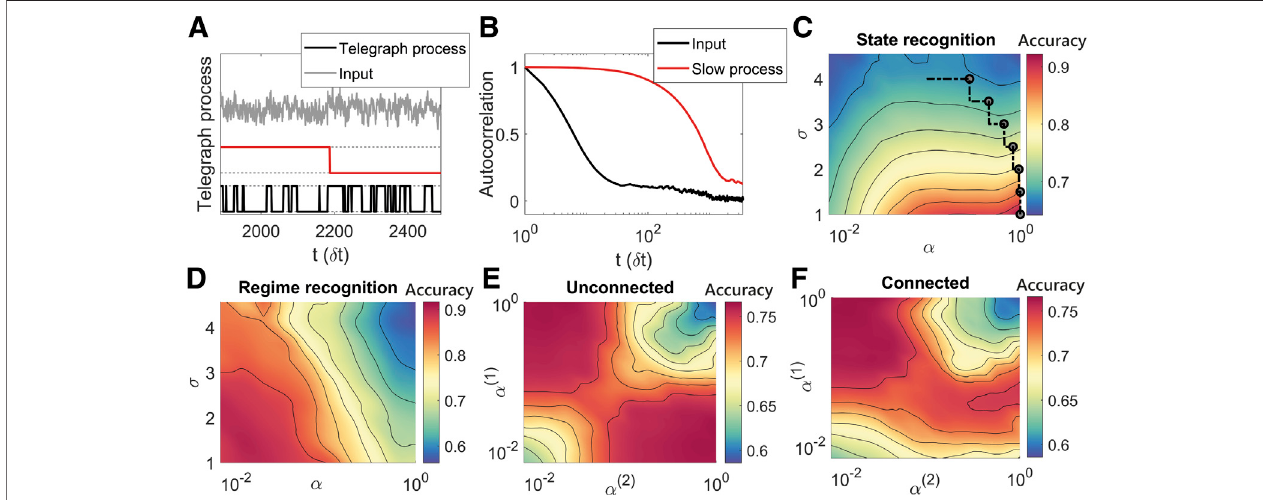
FIGURE4| Thebeststructureandparametersofthemodeldependonthespeci fi cenvironmentconsidered,thatisdifferentvaluesoftheadditivenoiseintheinput signal,and on thespeci fi c desired output. (A) : Example ofinputsignal and ofits generativeprocesses, which have afaster and aslower dynamic respectively. When the slowerprocess(redline)is up ( down ),theothersignalisinaregimewheretheaveragetimeinthezero(one)stateisgreaterthantheaveragetimespentintheotherstate. Theinputsignal(grayline)correspondstothefasterprocess(blackline)withadditionalwhitenoise. (B) :Auto-correlationstructureofthetwogenerativeprocesses. (C) :TheaccuracysurfaceforasingleESNonthestaterecognitionsub-taskforvaryinglevelofnoise( σ )andleakagerateofthenetworkshowingthatforincreasinglevels of noise a lower leakage rate is needed to determine the state. The line shows the trajectory of α using the online learning method when the strength of the noise is changed. (D) : The accuracy for a single ESN on the regime recognition sub-task for varying noise and leakage rate. In this case the low leakage rate is preferred for all values of noise. (E) : Accuracy surface for the state recognition sub-task for an unconnected hierarchical ESN showing how either of the leakage rates must be low while theotherishigh. (F) :Accuracysurfacefortheregimerecognitionsub-taskforahierarchicalESNshowingthe fi rstreservoirmusthaveahighleakagerateandthesecond a low leakage rate.